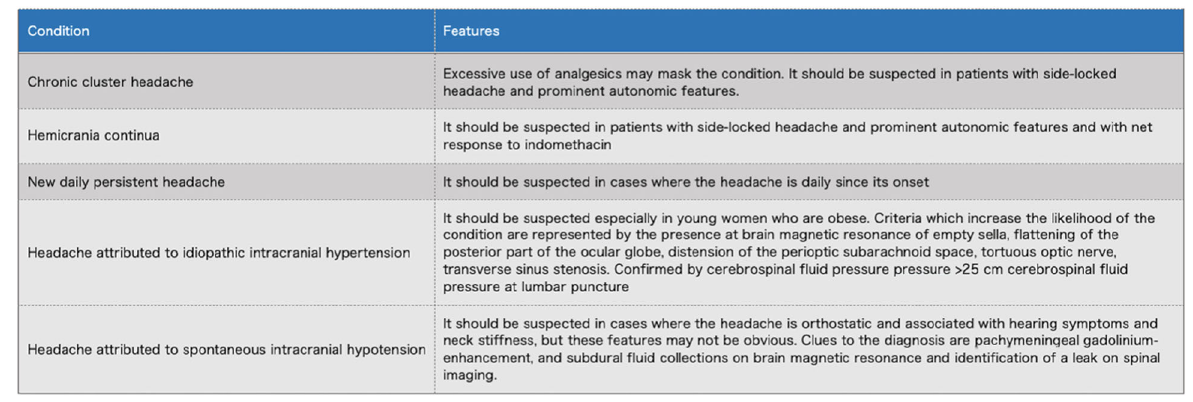
Table 6 Conditions to be excluded before diagnosis of resistant or refractory